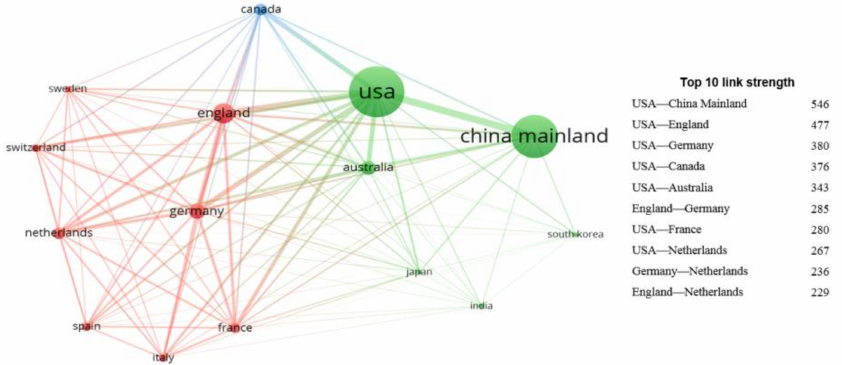
Figure 3. Collaboration network of top 15 countries / territories in the environmental sciences